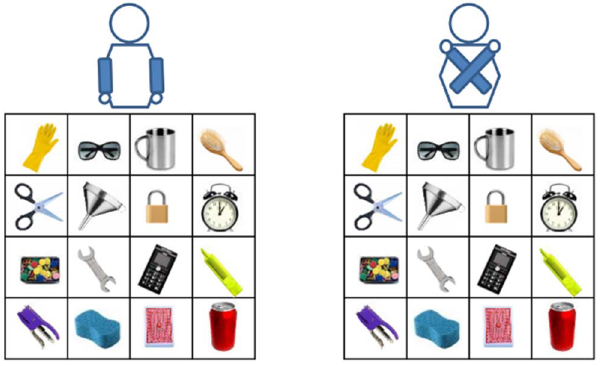
Figure 1. Schematic representation of the set-up and stimuli of Experiment 1. Left and right panels represent uncrossed and crossed arm posture conditions, respectively. Please note that the objects shown and their displacement are illustrative and do not reflect those actually used.